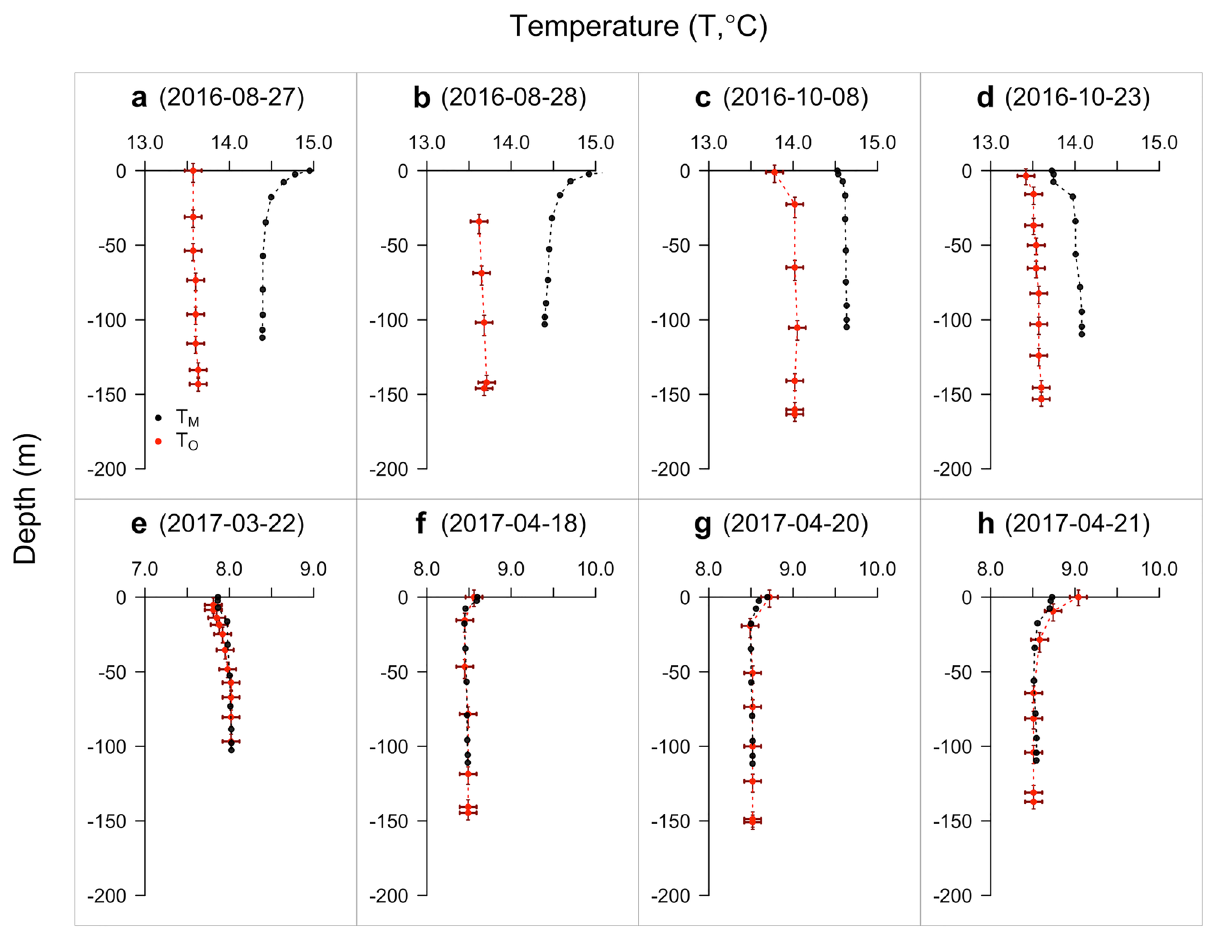
Figure 5. Temperature-depth profile validation. Each panel ( a–h ) shows a modelled (black) and observed (red) temperature-depth profile for a particular date. For profile b , near-surface temperature observations were not recorded. Note that the temperature axis differs among panels, but the range is constant (2 °C), so the panels are comparable. Differences between the depth of the seabed layer in the model and the maximum depth of individuals reflect local variation in bathymetry that is not resolved by the model mesh. Error bars mark uncertainty in temperature observations and the depths to which these